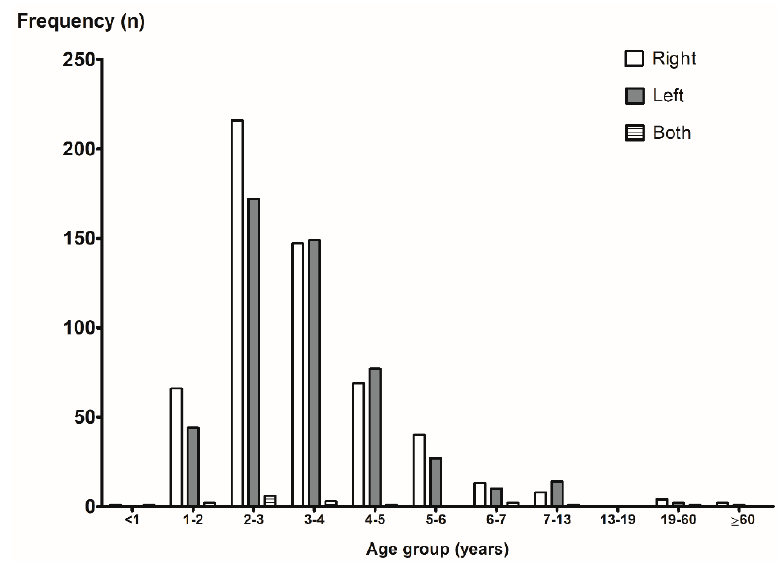
Figure 2. The frequencies of nasal foreign body according to the age group and location.